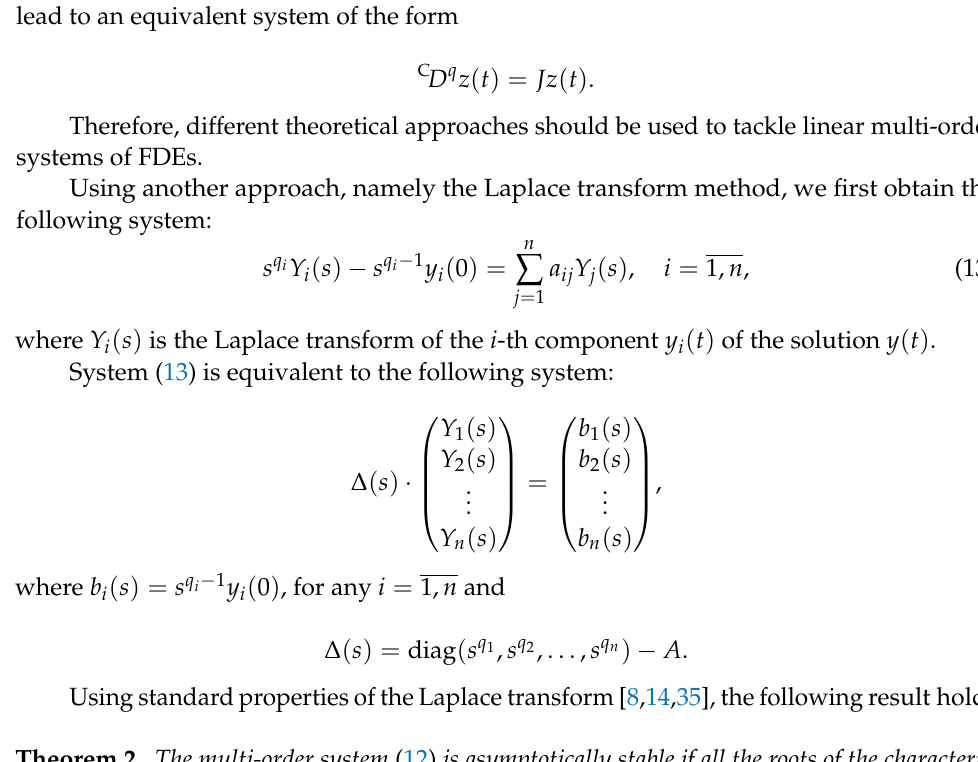
Figure 4. Solutions of the linear system C D q A = A 4 ( right